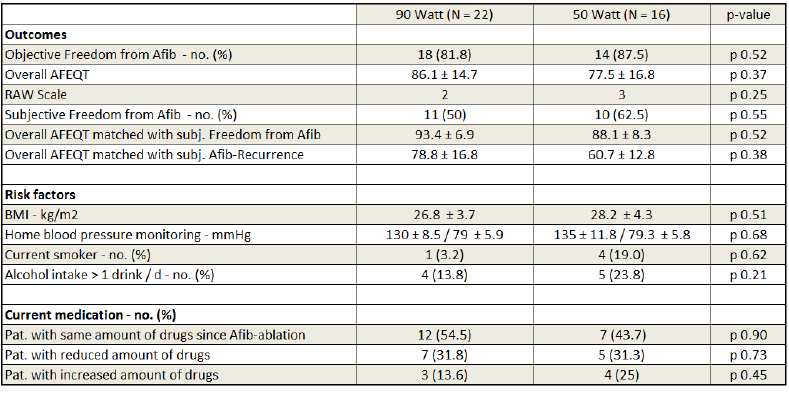
Figure 5. Detailed flow-chart overview of study population.